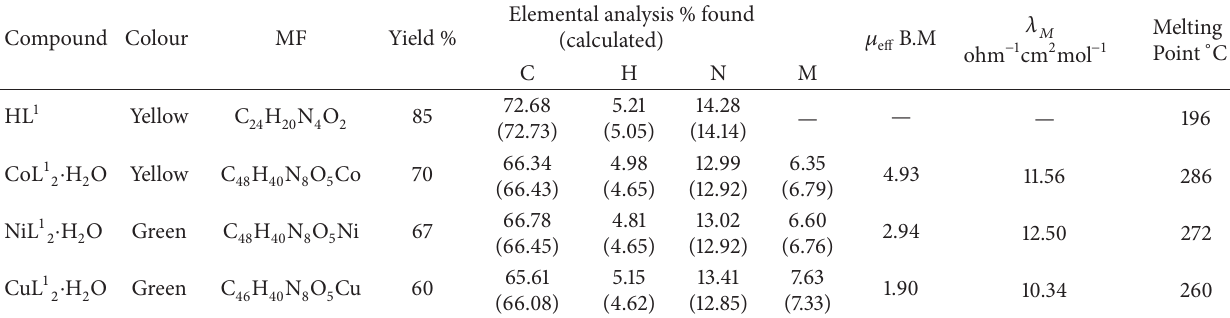
Table 3: Elemental analysis and physical data of the ligand and complexes.